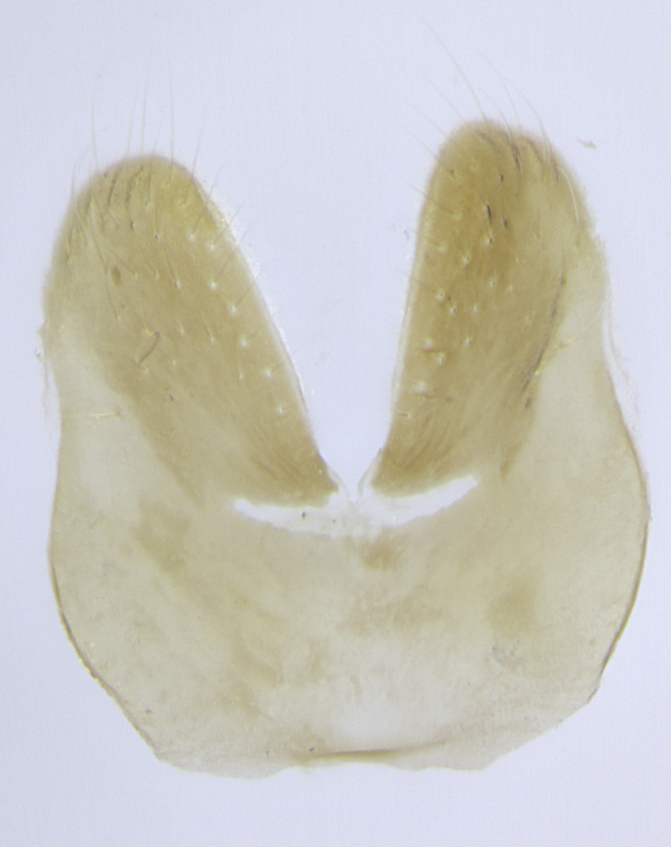
sternite 5, ventral view.